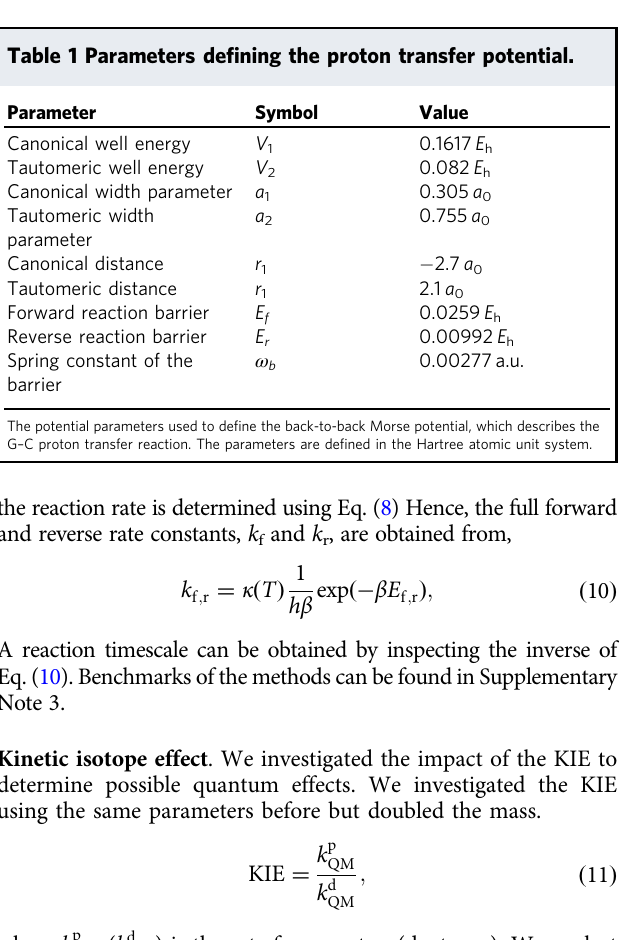
Table 1 Parameters de fi ning the proton transfer